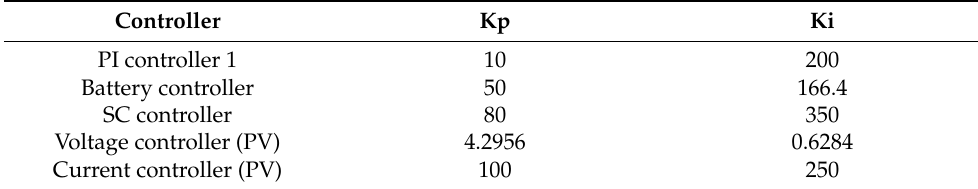
Table 1. Optimal values of PI controllers.